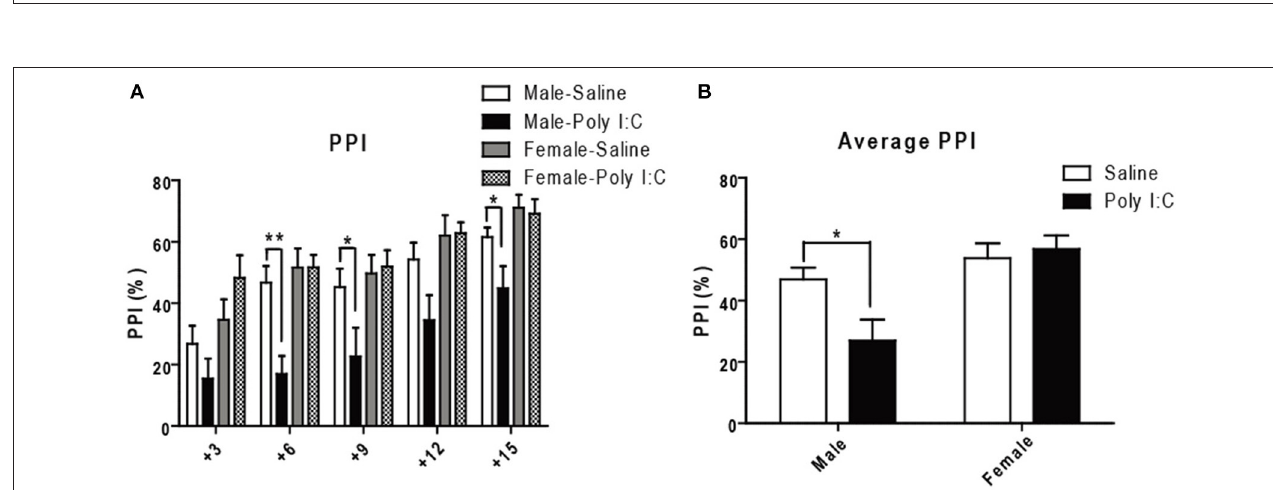
FIGURE 6 | Effects of Poly I:C on sensorimotor gating activity under prepulse inhibition paradigm. (A) Sensorimotor gating was determined by calculating percentage reduction of startle amplitude using five prepulses (3–15 dB higher than background noise) administered before the 120 dB startle tone. (B) The average reduction of startle amplitude is shown. n = 7–9 mice per sex and group. * p < 0.05, ** p < 0.01.